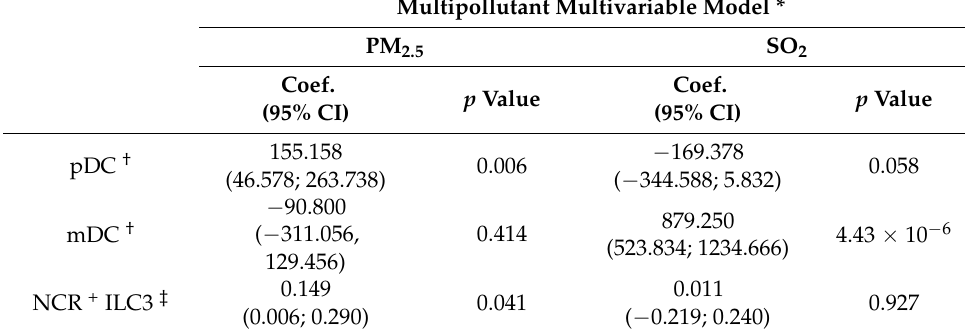
Table 7. Multipollutant multivariable regression models of cord blood cells and pollutants previously associated in PCA. PC2 from air pollutants and PC4 from cell types with ≥ 0.4 for the highest loadings and ≤− 0.4 for the lowest loadings. After Bonferroni correction, significance was considered when p < 0.008. Multipollutant Multivariable Model * PM 2.5 SO 2 Coef. p Value (95% CI)